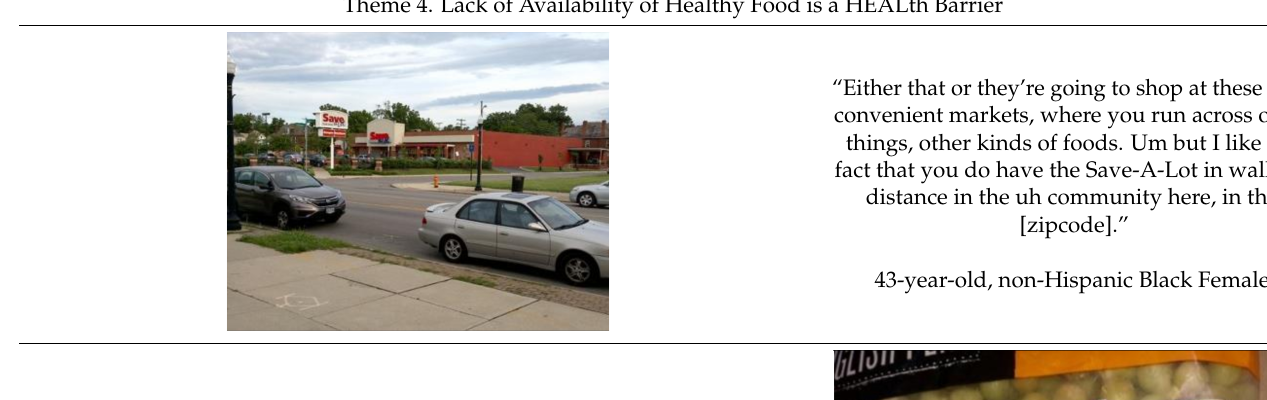
Table 2. Cont. Representative Quote(s) from Project SWEAT HEALth MAPPS Participant In-depth Interviews and Focus Groups and Image(s) Captured by Project SWEAT HEALth MAPPS Participants using the Garmin Oregon 650 Theme 4. Lack of Availability of Healthy Food is a HEALth